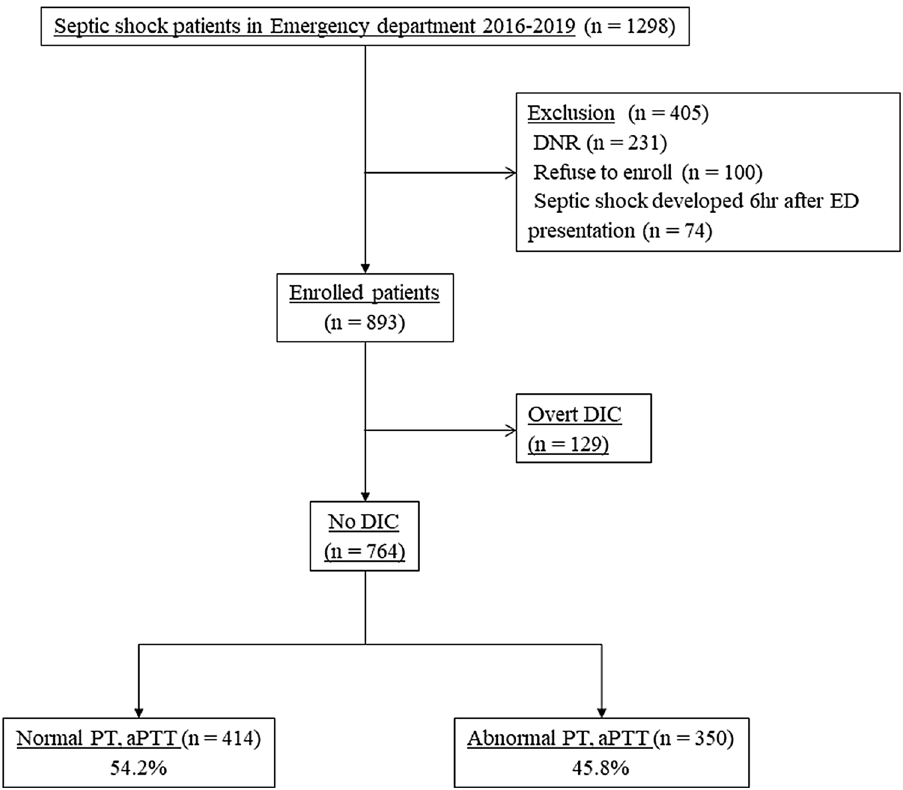
Figure 2. Flow diagram of the study subjects. TEG thromboelastography; DNR do not resuscitate; ED emergency department; DIC disseminated intravascular coagulation; PT prothrombin time; aPTT activated partial thromboplastin time.